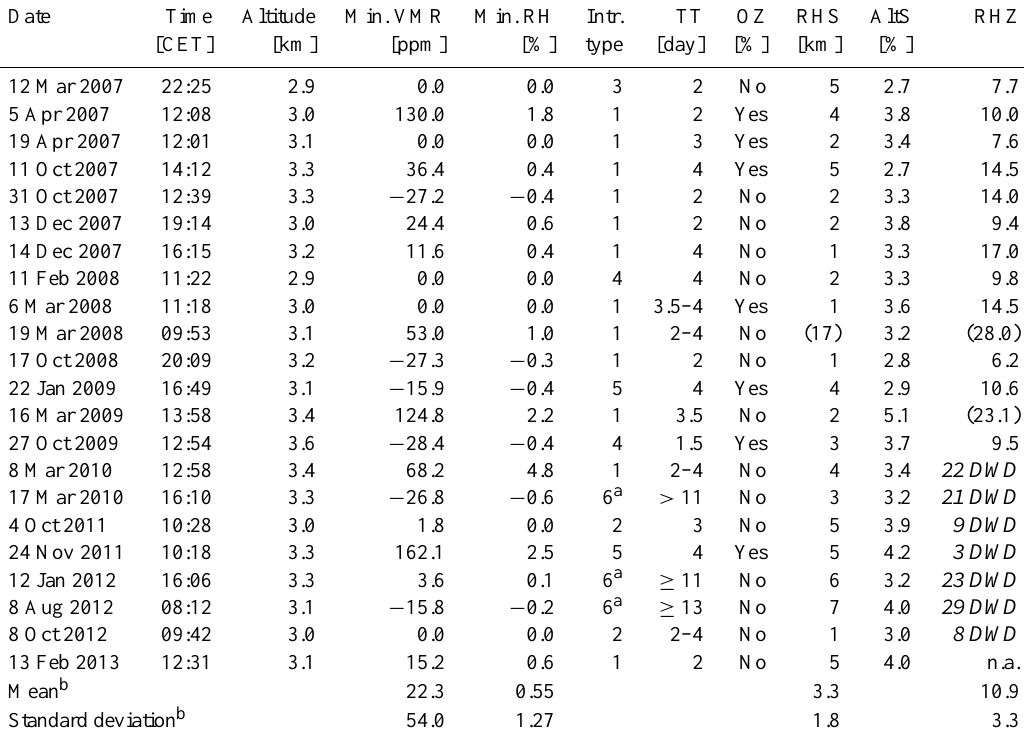
Table 1. List of minimum humidity values (volume mixing ratio, VMR, and RH) in stratospheric air intrusions detected with the water- vapour DIAL; only intrusions that descended to 3.6km and less and (with one exception) observed at the Zugspitze summit were included; the values are compared with minimum-RH data from the Munich or Stuttgart radiosonde (RHS; AltS: layer altitude in sonde measurement) and the Zugspitze summit station (RHZ; in italics: from DWD). The intrusion types are listed as defined by Trickl et al. (2010). The crude travel time (TT) is estimated from the trajectory results. OZ: measurement(s) of ozone DIAL available; AltM: altitude of sonde minimum